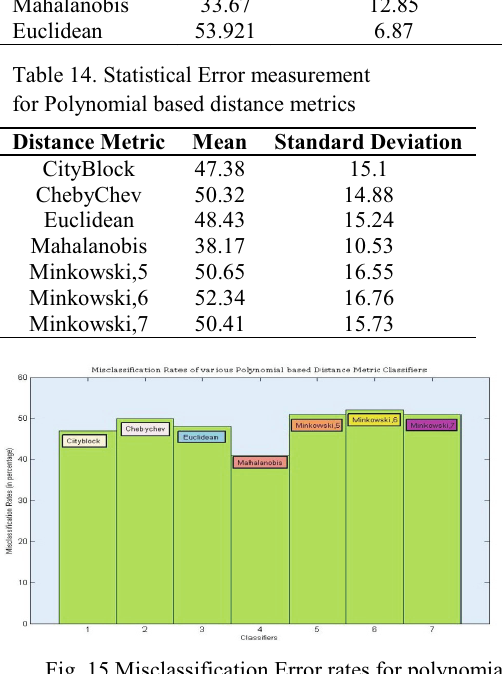
Fig. 15.Misclassification Error rates for polynomial based distance